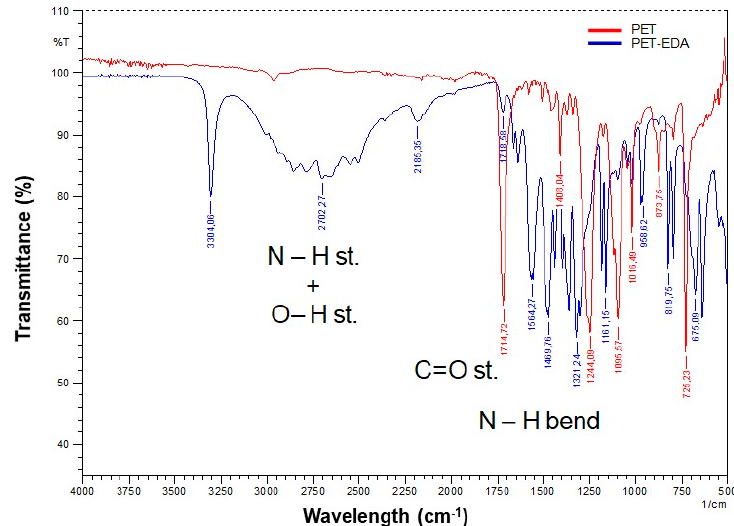
Figure 3. ATR–FTIR spectra of the neat electrospun poly(ethylene terephthalate) (PET) fiber mat and the aminated PET (APET) electrospun fiber mat.